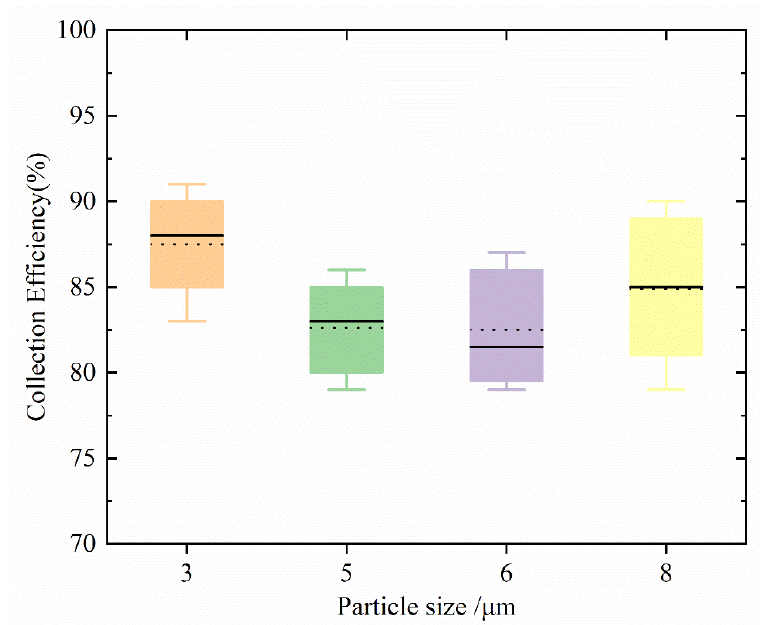
Figure 10. Enrichment Experiment Statistics Box Plot.